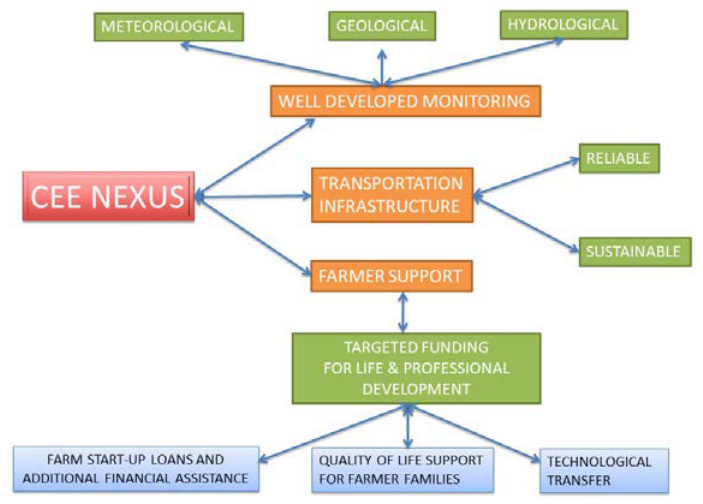
Fig. 4. WEF supporting pillars (Source: the